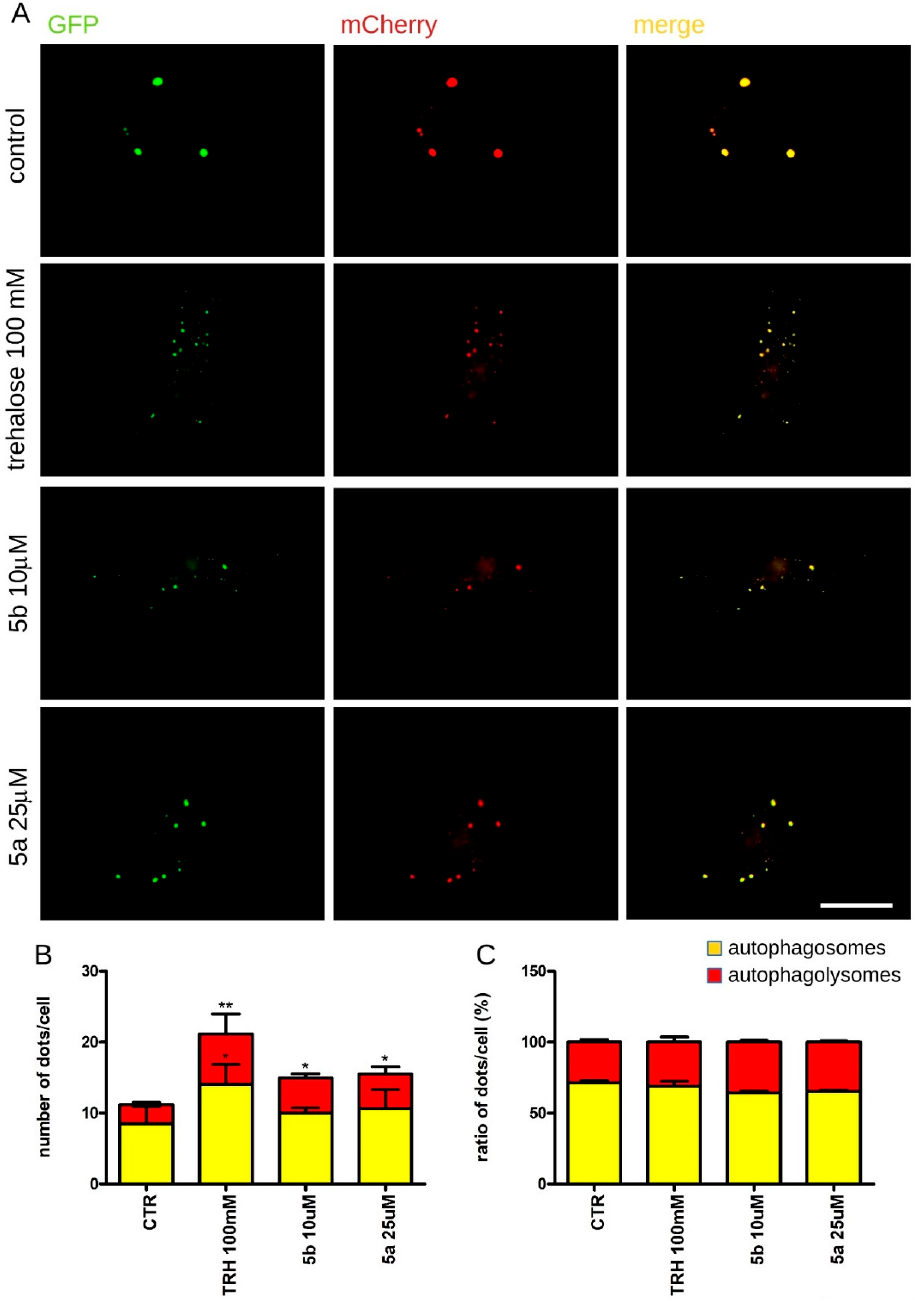
Figure 5. Assessment of autophagy by imaging approaches. We investigated the autophagic flux by a GFP-mCherry-LC3B reporter. Non-acidic autophagosomes appear as green and red dots, while autophagolysomes are red. ( A ) Image-based investigation of autophagy upon expression of the reporter GFP-mCherry-LC3B in HeLa cells treated for 24 h with trehalose (100 mM), 5b (10 μ M) and 5a (25 μ M). Scale bar = 10 μ m. ( B ) The graph reports the number of autophagosomes (yellow) and autophagolysomes (red) present in each cell. Data are expressed as mean ± S.E.; * p < 0.05, ** p < 0.01 vs. control, n = 10–15 for each experiment, 3 independent experiments. ( C ) The graph reports the percentage of autophagosomes (yellow) and autophagolysomes (red) present in each cell. Data are expressed as mean ± S.E.; * p < 0.05, ** p < 0.01 vs. control, n = 10–15 for each experiment, 3 independent experiments.